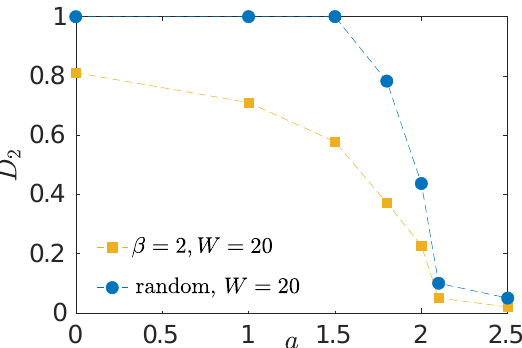
versus power a for 2